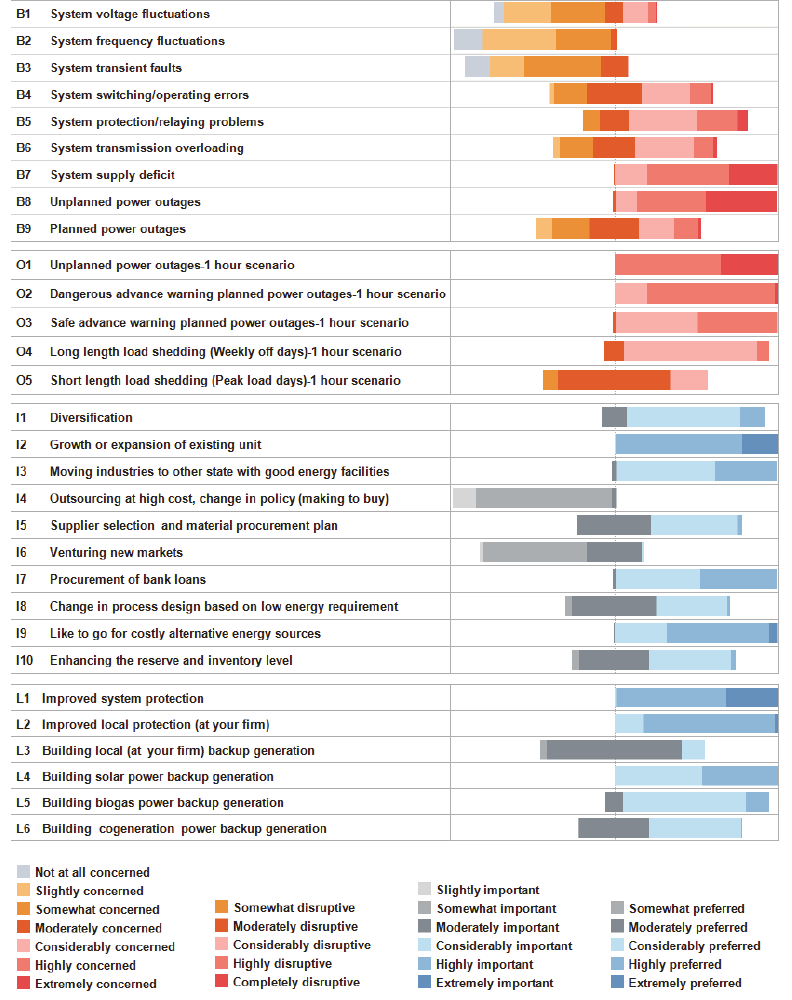
Fig. 2. Data visualization of the categorical seven-point Likert item scale for all the sections